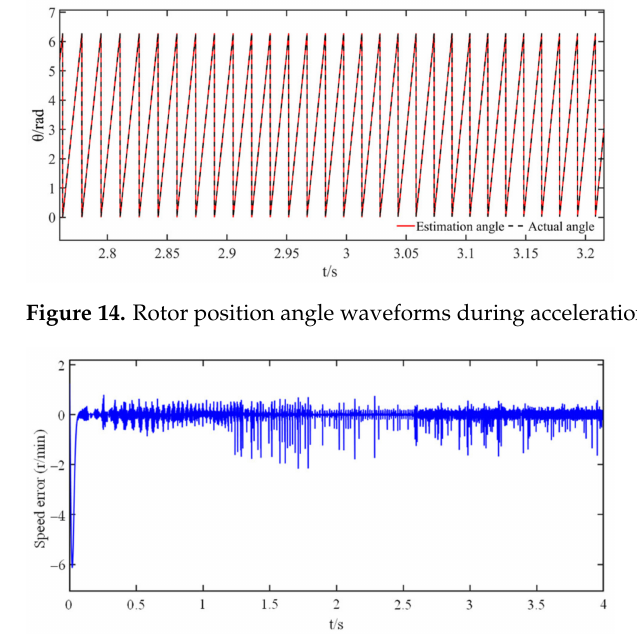
Figure 13. Speed waveforms for increasing speed from 500 r/min to 1000 r/min.